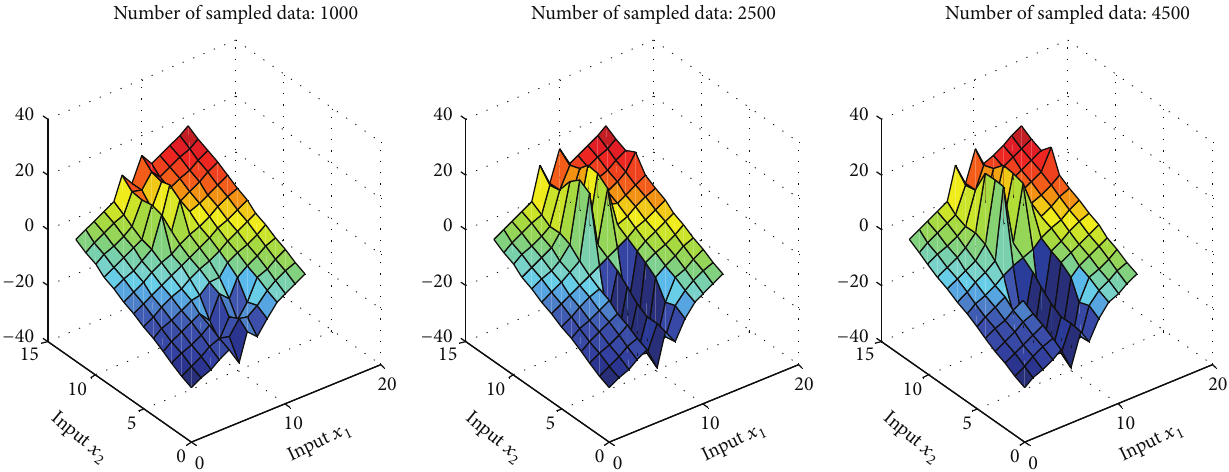
Figure 9: Training result of predesigned fuzzy surface.